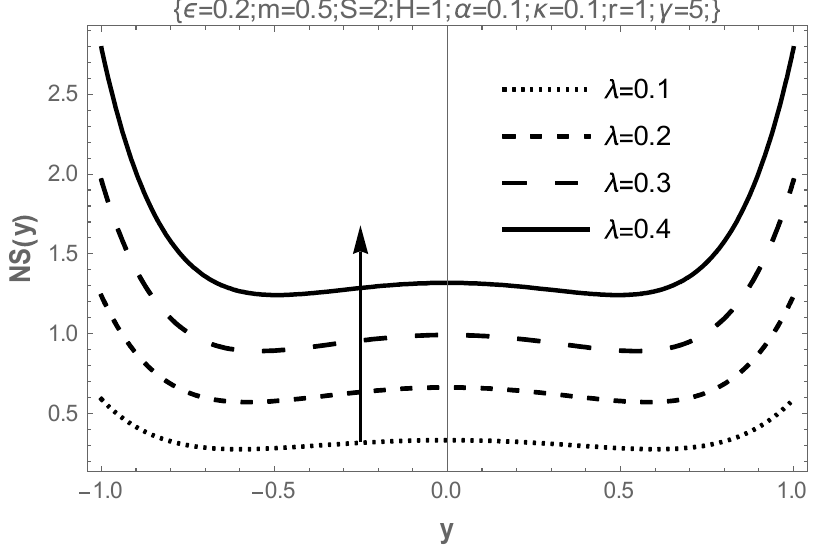
Figure 4. Effect of the Frank–Kameneskii parameter on entropy profile.